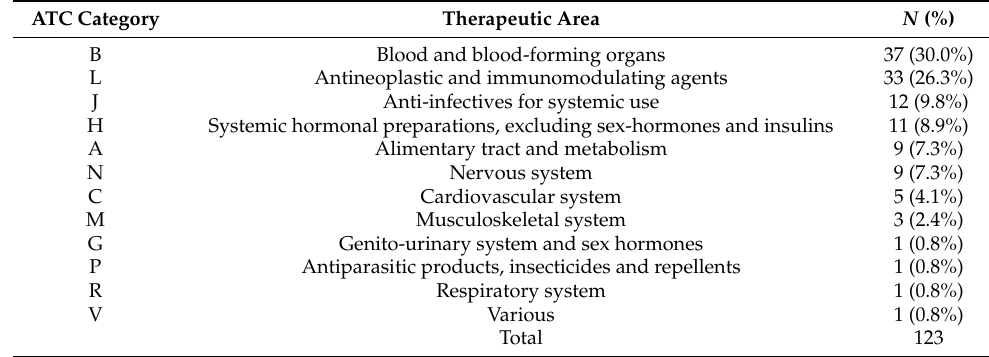
Table 4. The Anatomical Therapeutic Chemical (ATC) classification system of involved drugs.